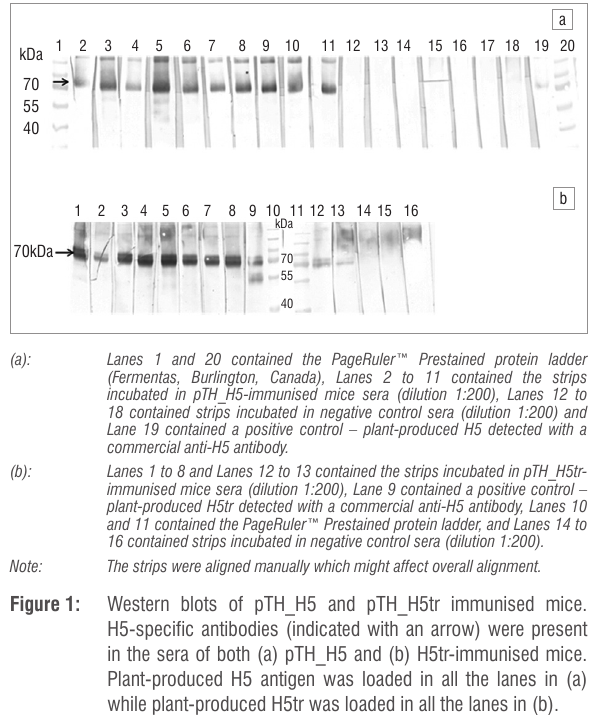
Figure 1: Western blots of pTH_H5 and pTH_H5tr immunised mice. H5-specific antibodies (indicated with an arrow) were present in the sera of both (a) pTH_H5 and (b) H5tr-immunised mice. Plant-produced H5 antigen was loaded in all the lanes in (a) while plant-produced H5tr was loaded in all the lanes in